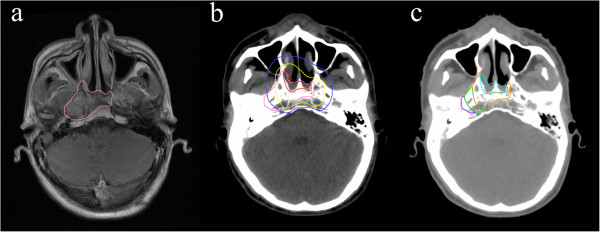
Delineation of target volumes. (a) The gross recurrent tumor volume (GTVr) was identified on MRI images. (b) The GTVr was transferred to the original planning CT. Red line is gross tumor volume (GTV); yellow line, CTV1; blue line, CTV2. (c) Cyan line, TG; orange line, TC1; green line, TC2; purple line, TE; TG+TC1+TC2+TE=GTVr.